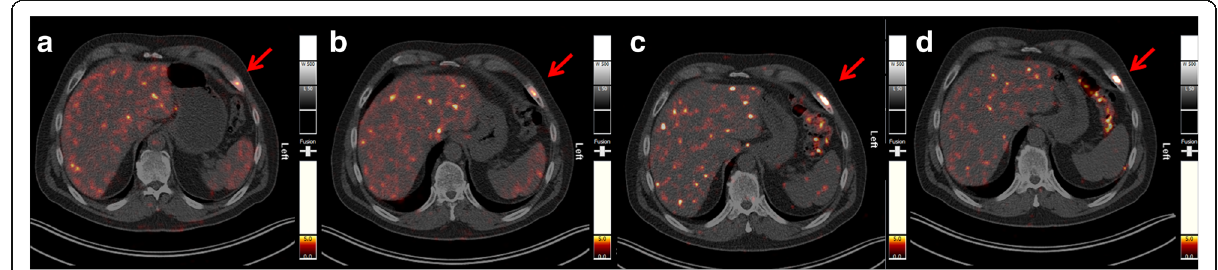
Fig. 4 PET/CT scans (transversal slices through the upper abdomen at the level of the liver and spleen) obtained at a 50 min, b 2 h, c 18.5 h, and d 25 h, respectively after injection of 140 MBq 152 Tb-PSMA-617, clearly demonstrating a PSMA-avid bone metastasis in the ventrolateral part of the left 7th rib (red arrow) with maximum uptake at 18.5 and 25 h